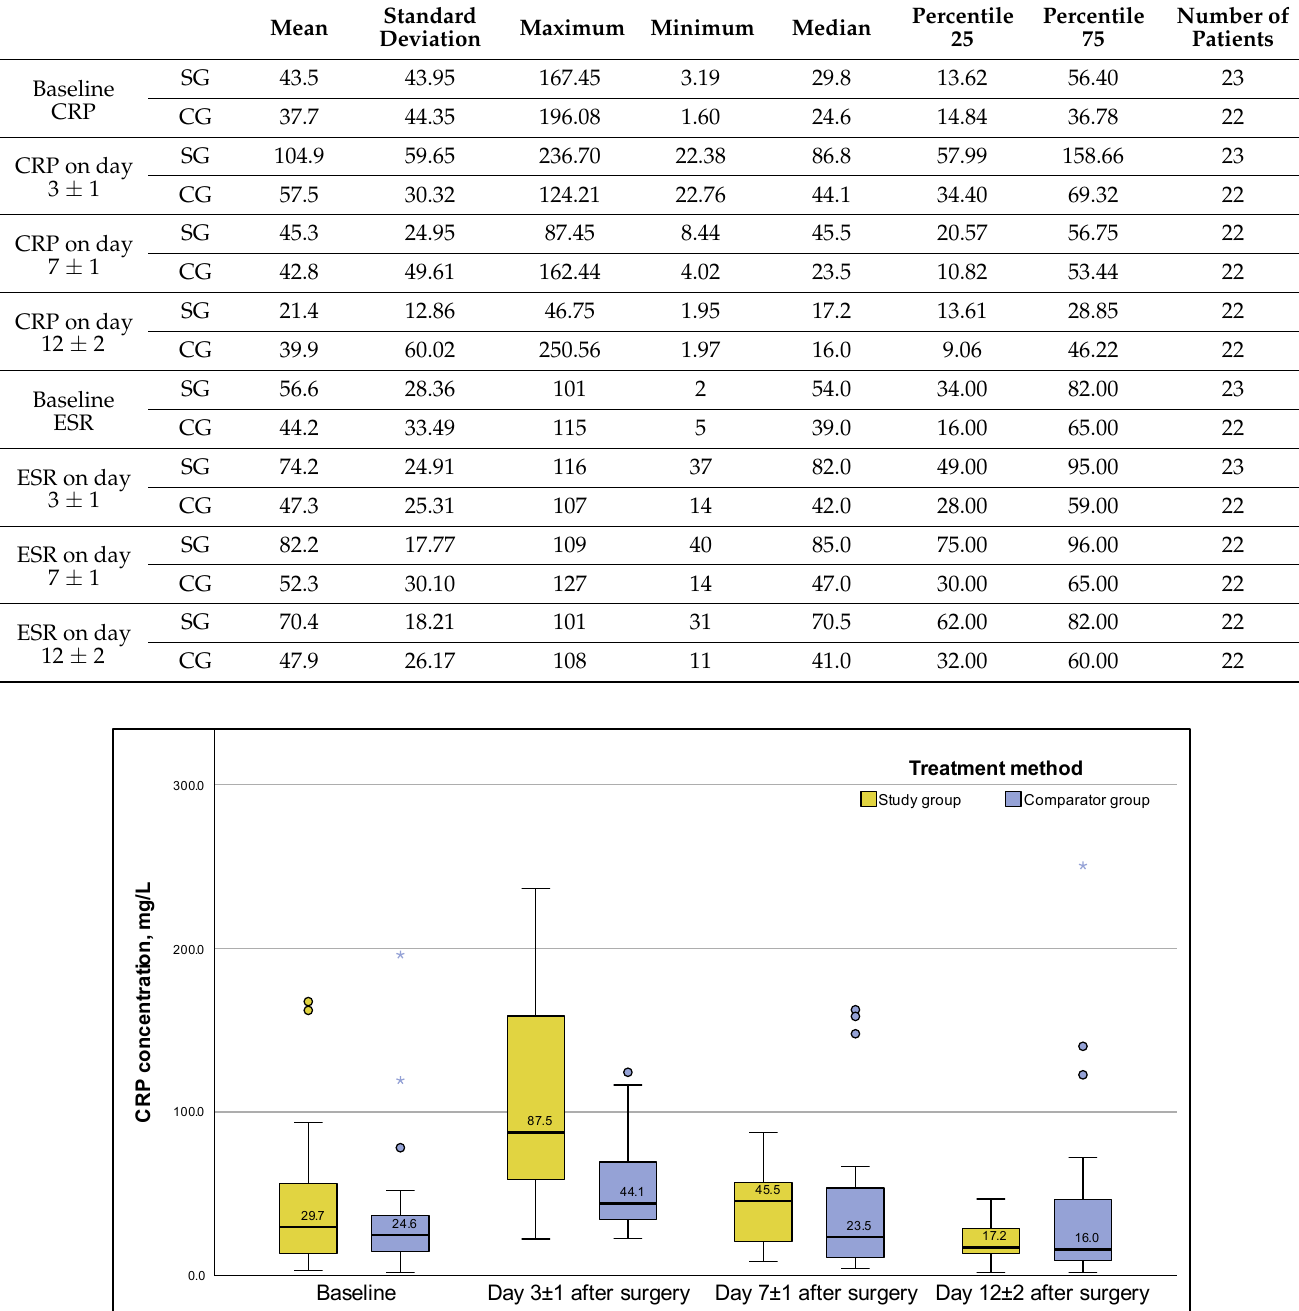
Table 5. Descriptive statistics for CRP (mg/L) and ESR (mm/hour) values during PJI treatment after revision surgery (ITT population).